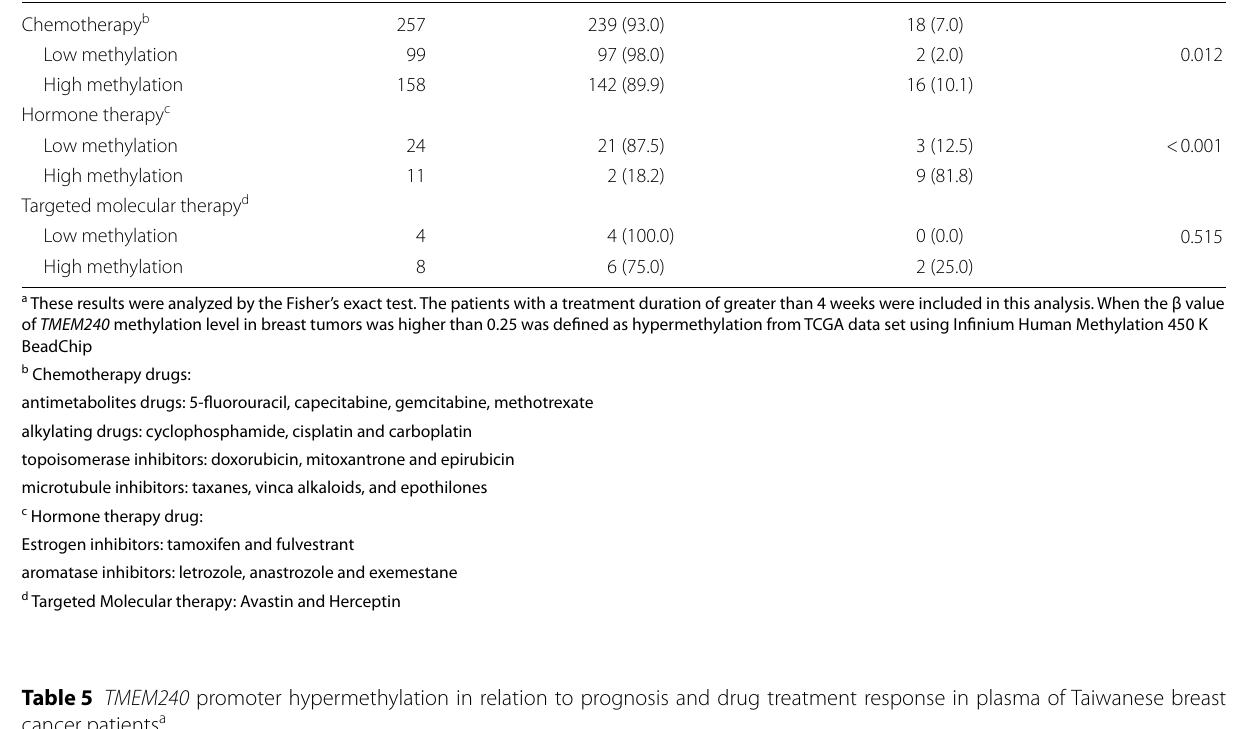
cancer patients